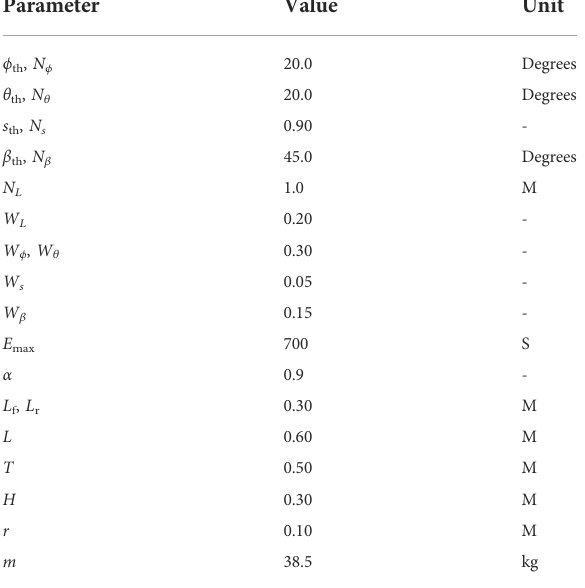
TABLE 1 Parameters used in the